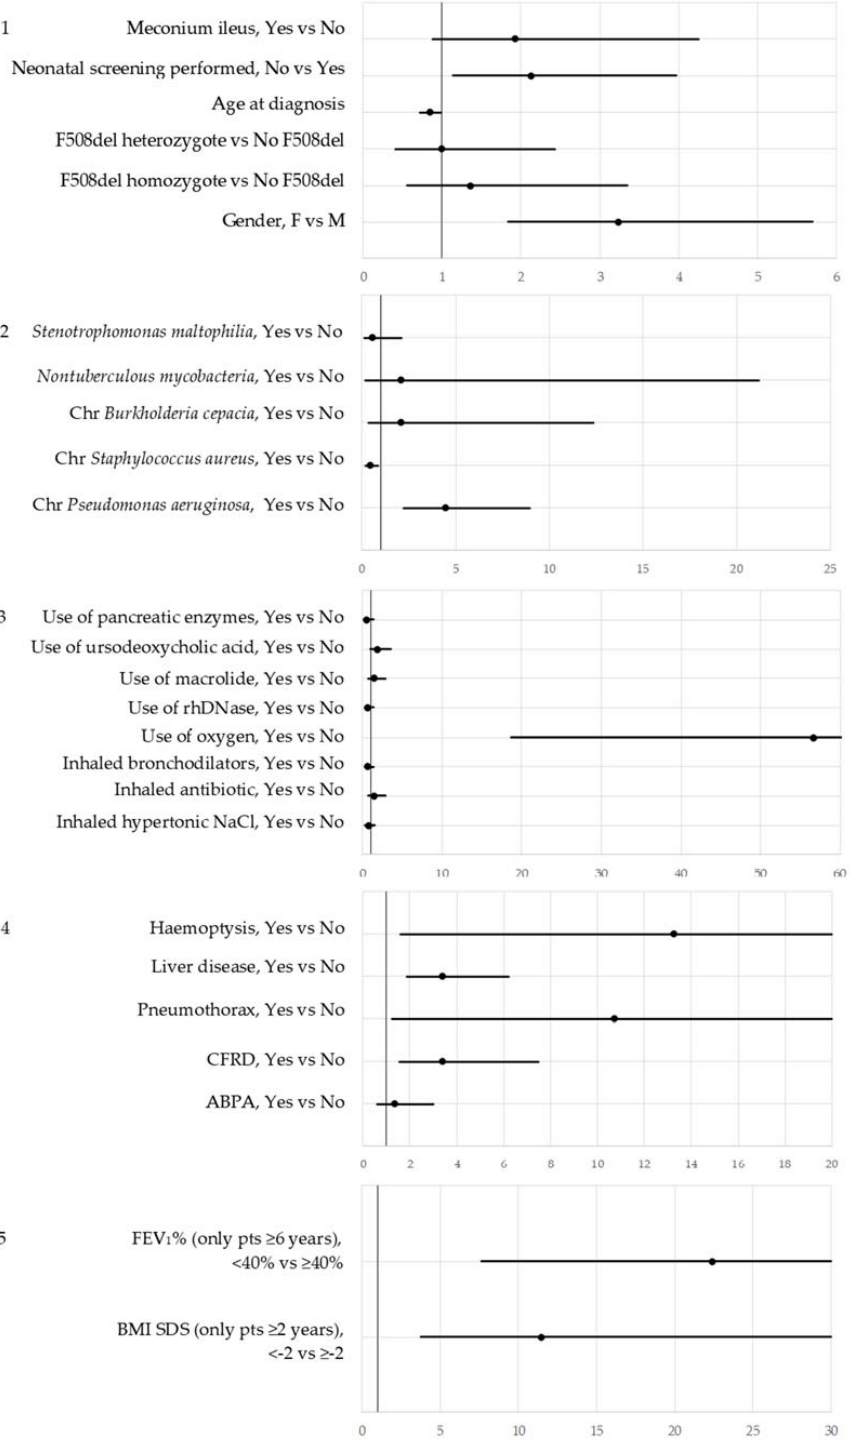
Figure 1. Results of the first step strategy: they are expressed as OR and 95% confidence interval (CI). All factors, among those recorded in the ECFSPR, were grouped in five classes: diagnosis ( 1 ), microbiology ( 2 ), therapies ( 3 ), complications ( 4 ), growth and lung function ( 5 ), Chr: chronic. All these variables were considered in the second step of the analysis, except haemoptysis and pneumothorax requiring chest drain (only 1 alive patient with one of these conditions). Among these variables (except BMI-SDS and FEV 1 %, available only for patients over 2 and 6